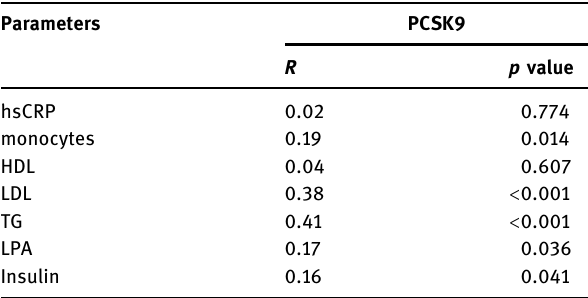
Table 3: Correlations between the selected laboratory parameters and PCSK9 concentrations Parameters